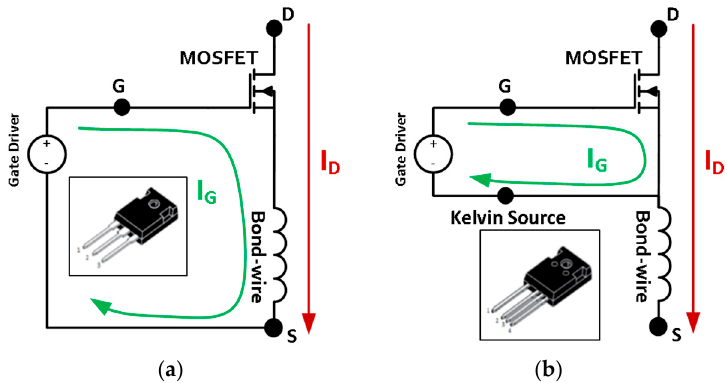
Figure 1. ( a ) Traditional three-terminal power semiconductor; ( b ) four-terminal power semiconductor containing a kelvin-source terminal for the gate voltage reference.